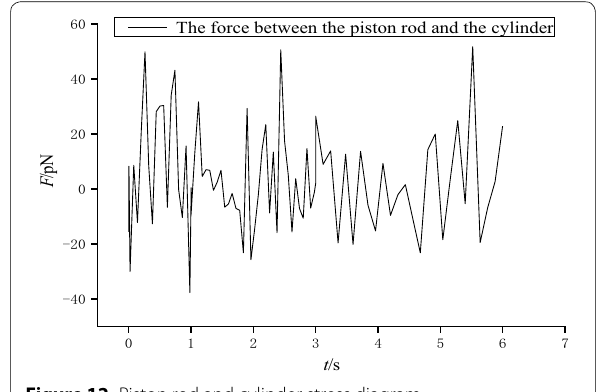
Figure 12 Piston rod and cylinder stress diagram